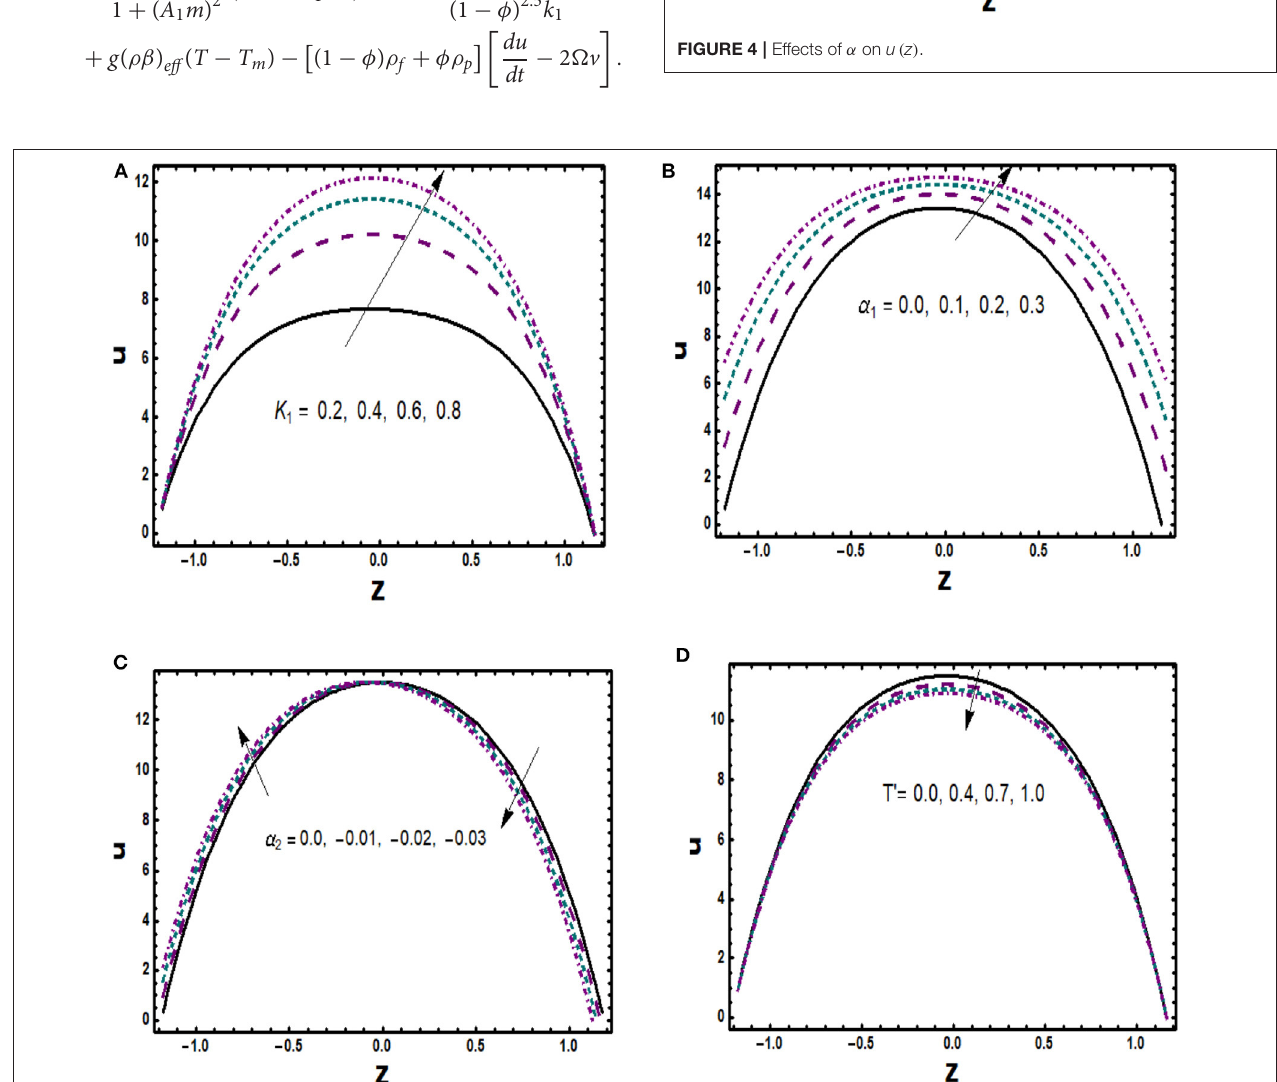
FIGURE 3 | (A–D) Effects of K 1 , α 1 , α 2 , and T ′ on u ( z ).